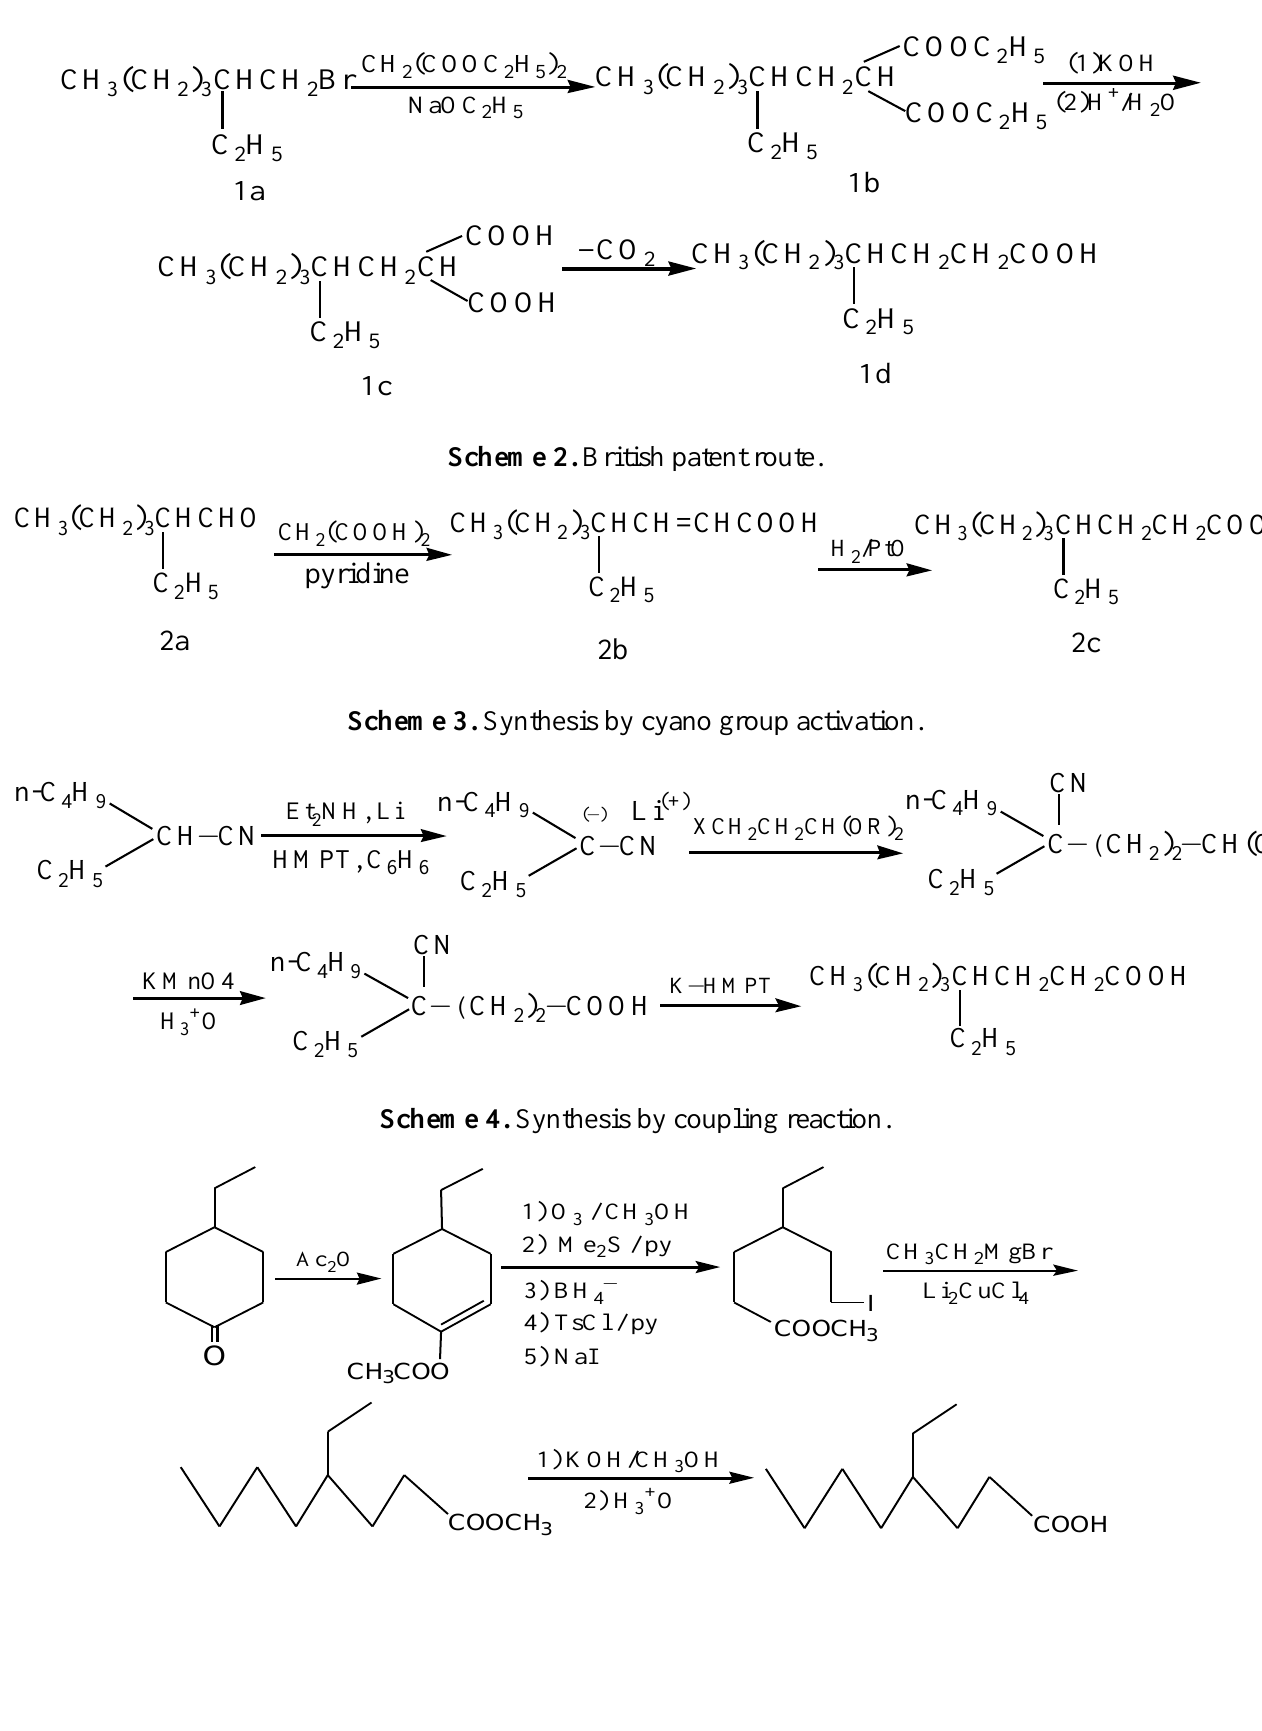
Scheme 1. S. G. Powell’s method.